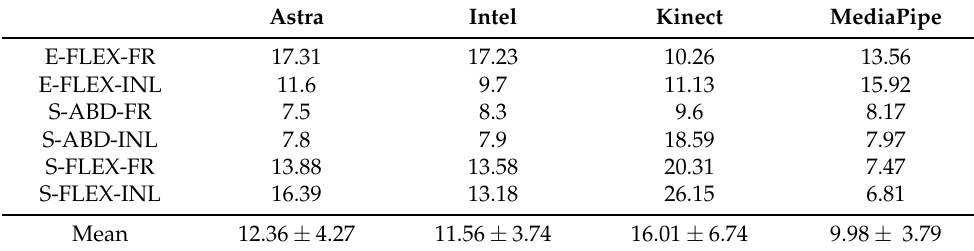
Table 10. Grouped box plots of the absolute error of each UE